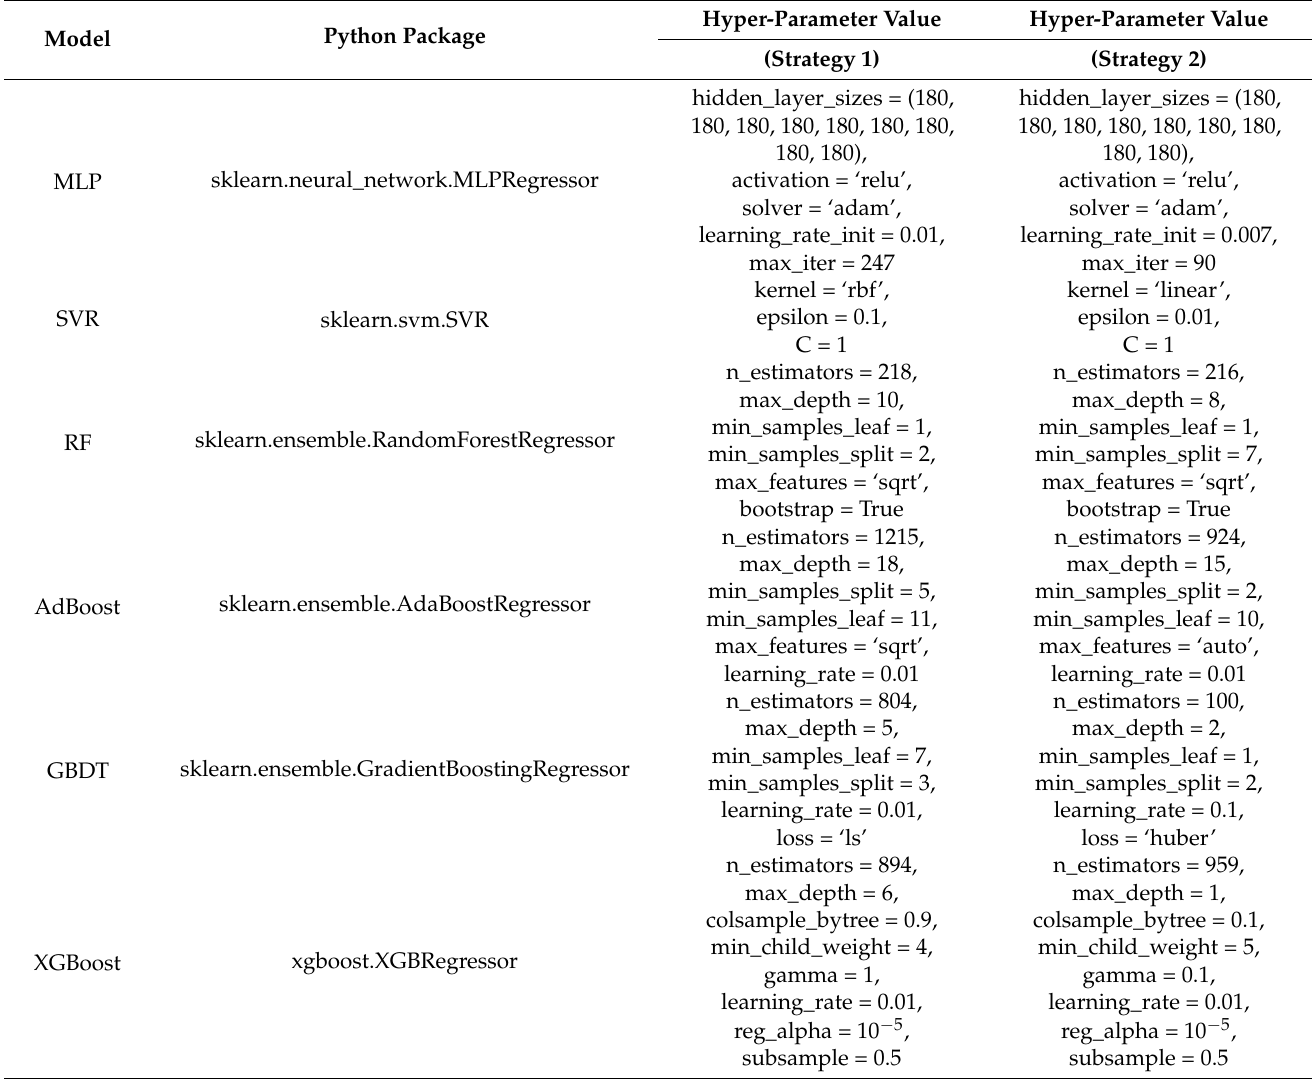
Table 6. The hyper-parameter optimization of artificial intelligence procedures for the crown pro- file